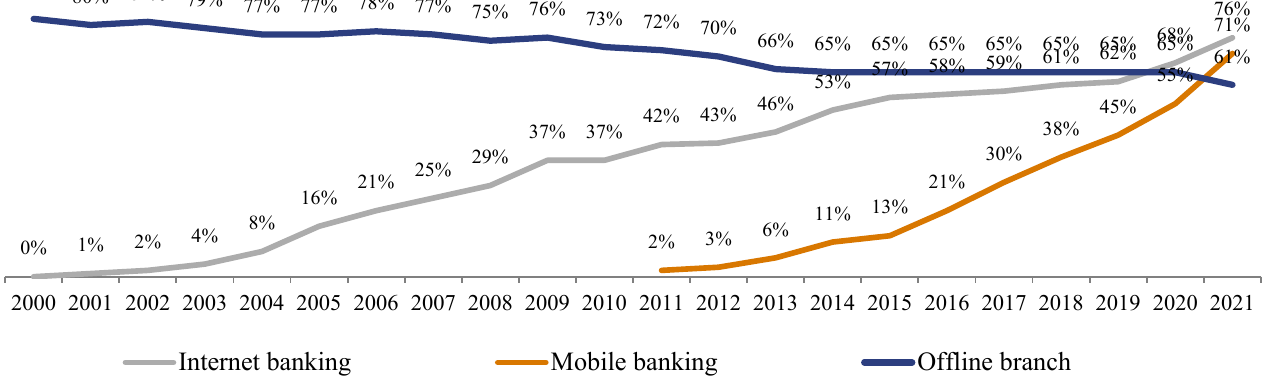
Figure 1. The percentage of customers using banking services in online and offline channels in Poland. Source: Kantar 2021.